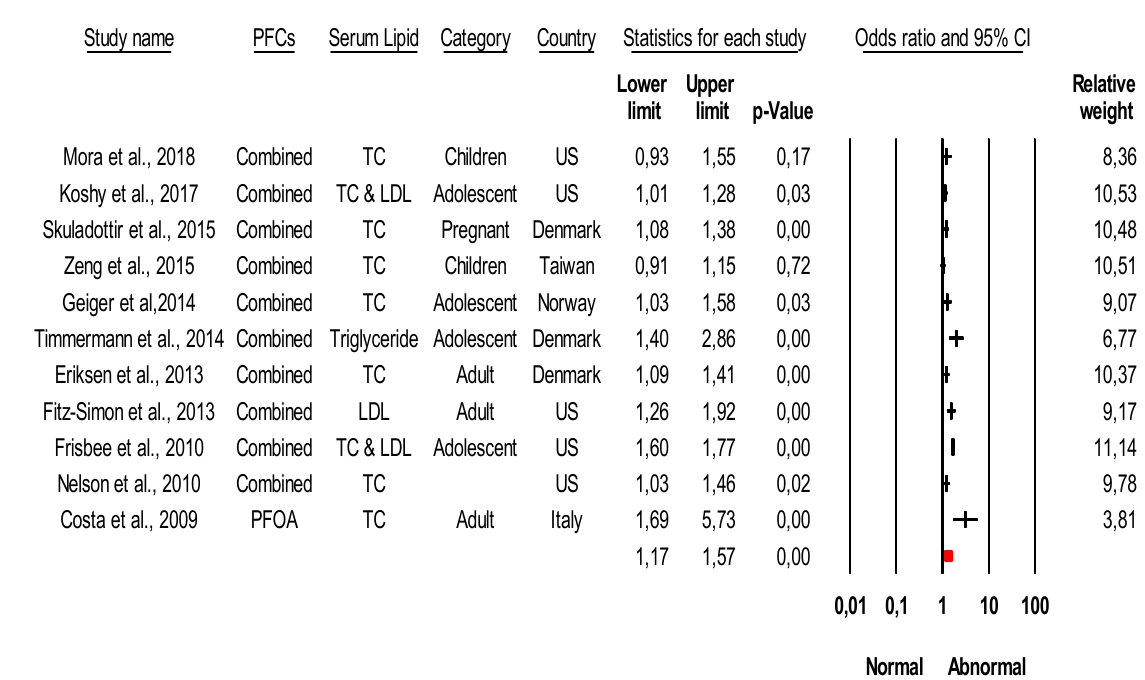
Figure 7. Meta-analysis of studies of PFCs exposure and serum lipid using the random-effects model, ordered by date of publication. TC = total cholesterol, LDL = low density lipoprotein. Test for overall effect: z = 4.04, p < 0.0001; Test for heterogeneity: I 2 = 85.2% Q = 110 df = 10, p <